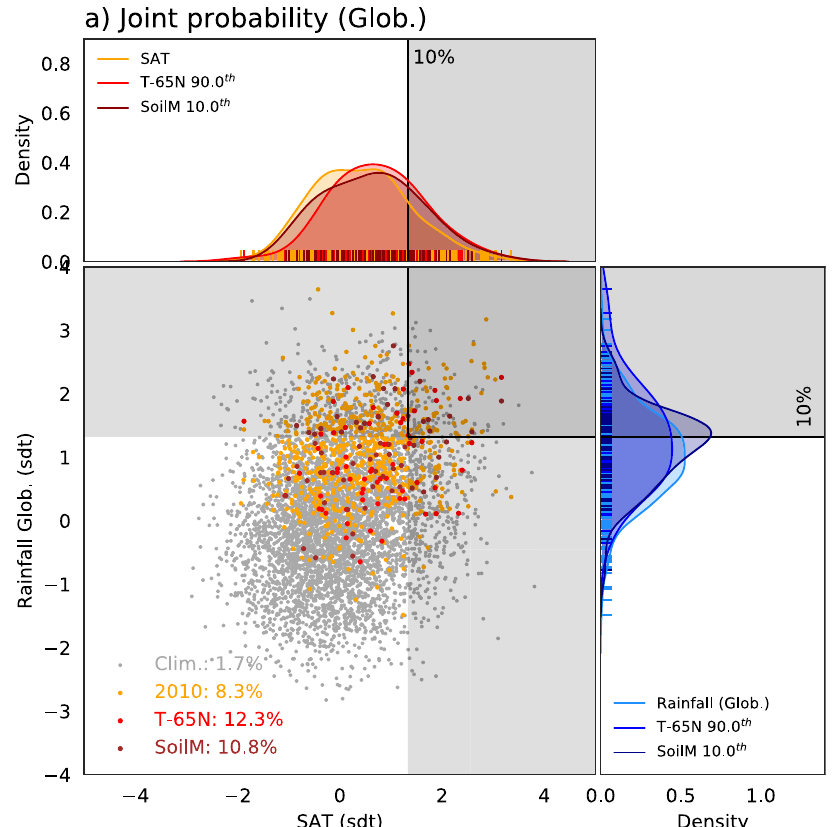
Fig. 8 Concurrent extremes, high-latitude land warming, and soil moisture. Top panel: PDF for WRussia SAT index in Glob2010 (solid orange line), Glob2010 | T65N (solid red line) and Glob2010 | soilM (solid brown line). The black solid line shows the 90 th WRussia SAT index (GlobClim) percentile. Bottom right panel: PDF for Pakistan Rainfall index in the 2010 ensemble (solid light blue line), Glob2010 | T65N (solid blue line), and Glob2010 | soilM (solid dark blue line). The black solid line shows the 90th Pakistan Rainfall index (GlobClim) percentile. Bottom left panel: scatter plot of Pakistan global Rainfall index on WRussia SAT for the GlobClim (gray dots, 4930 ensemble members), for the Glob2010 (orange dots, 649 ensemble members, of which 54 exceeding the 90th quantile for both WRussia SAT and Pakistan Rainfall indices), for Glob2010 | T65N (red dots, 65 ensemble members of which 8 also exceeding the 90th quantile for both WRussia SAT and Pakistan Rainfall indices) and Glob2010 | soilM (brown dots, 65 ensemble members, of which 7 also exceeding the 90th quantile for both WRussia SAT and Pakistan Rainfall indices). Concurrent events are highlighted in the top right gray-shaded area. Note that percentages for T-65N and SoilM are calculated by comparing the number of concurrent events that show T-65N (8) and SoilM (7) with the total number of T-65N and SoilM events in Glob2010 (65 each). The smoothing of the curve is done using a Gaussian kernel to produce continuous density